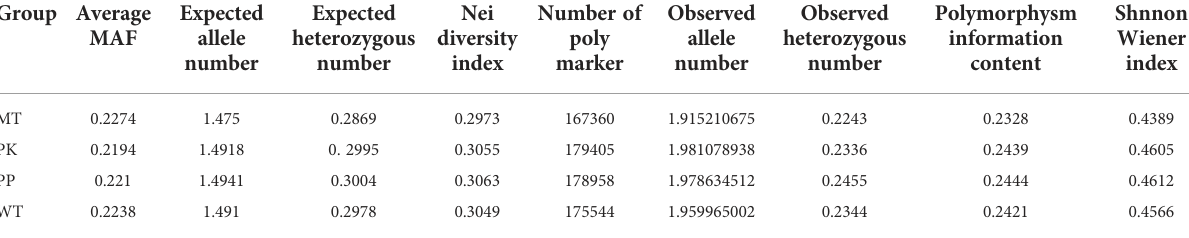
TABLE 2 Genetic diversity analysis of four P. lacti fl ora groups based on SNPs. Group Average